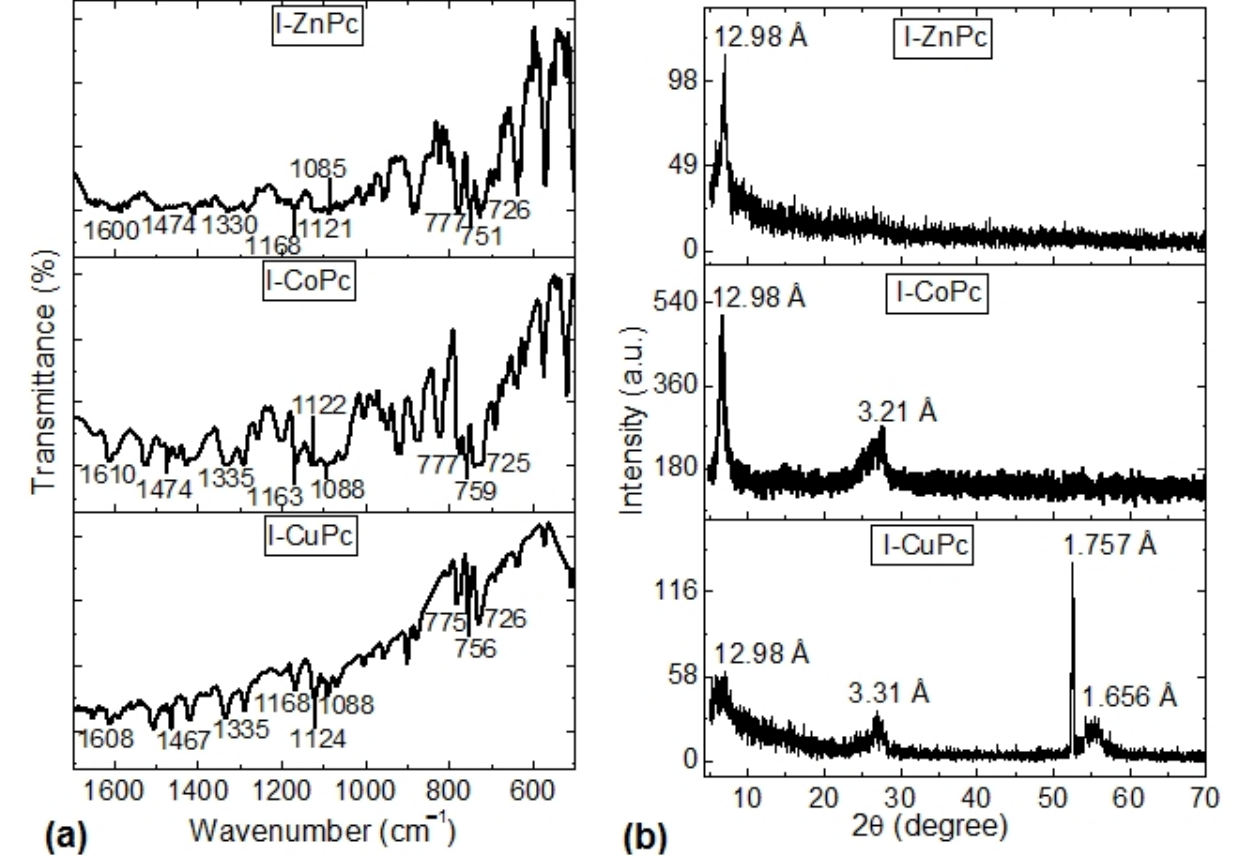
Figure 4. ( a ) IR spectrum and ( b ) XRD patterns of I-MPc films.